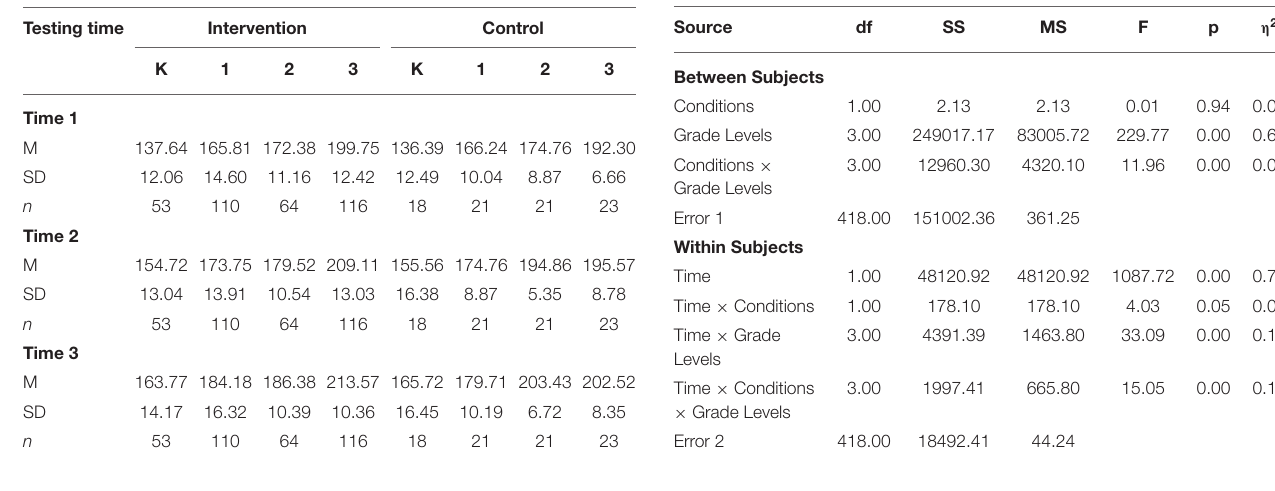
TABLE 1 | Means and standard deviations for student MAP test scores by grade levels in intervention and control conditions at three testing times. TABLE 2 | Analysis of variance results for student MAP test